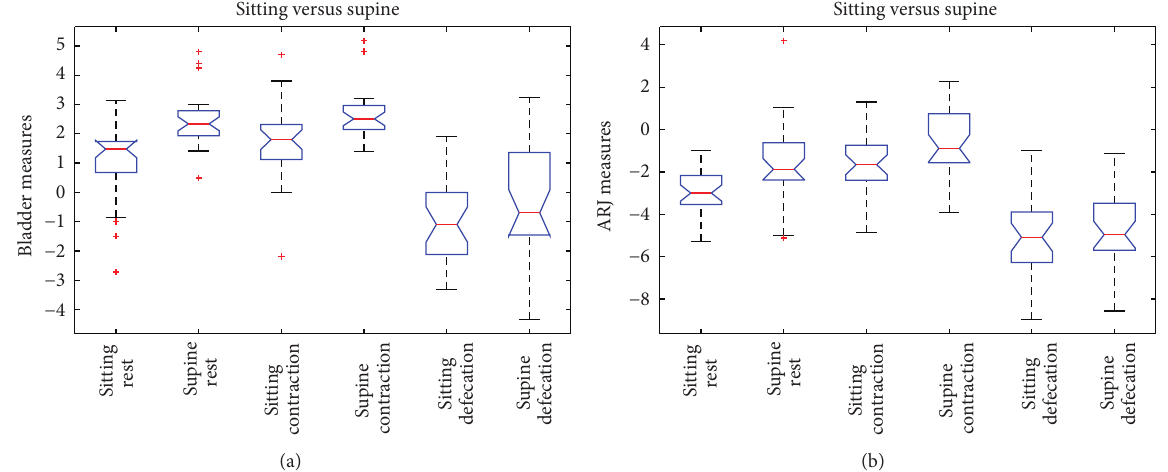
Figure 5: ANOVA box plot for bladder (a) and ARJ (b) measures of all the patients.